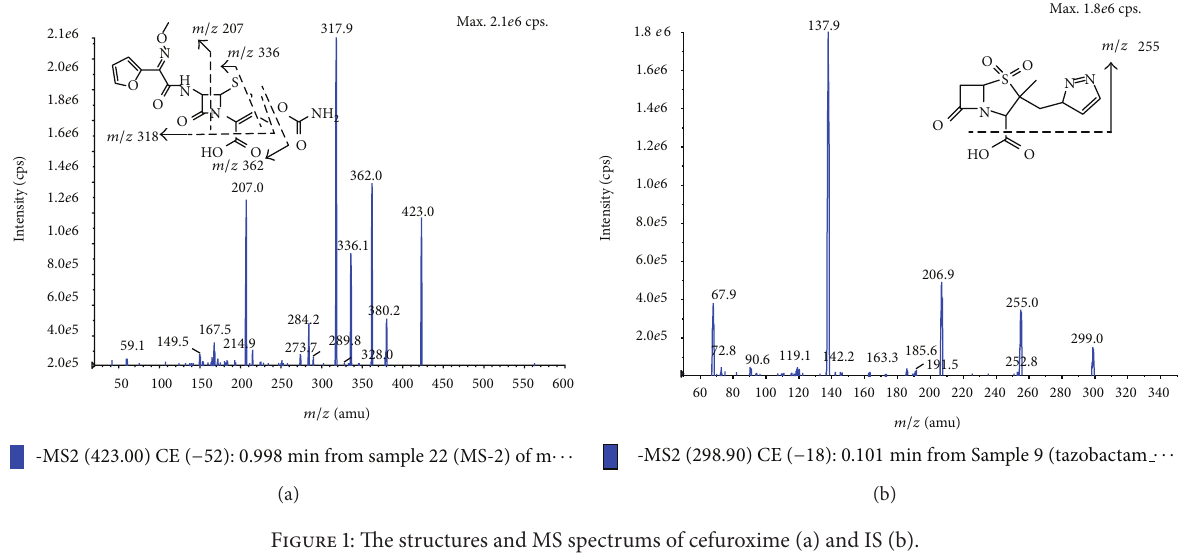
Figure 1: The structures and MS spectrums of cefuroxime (a) and IS